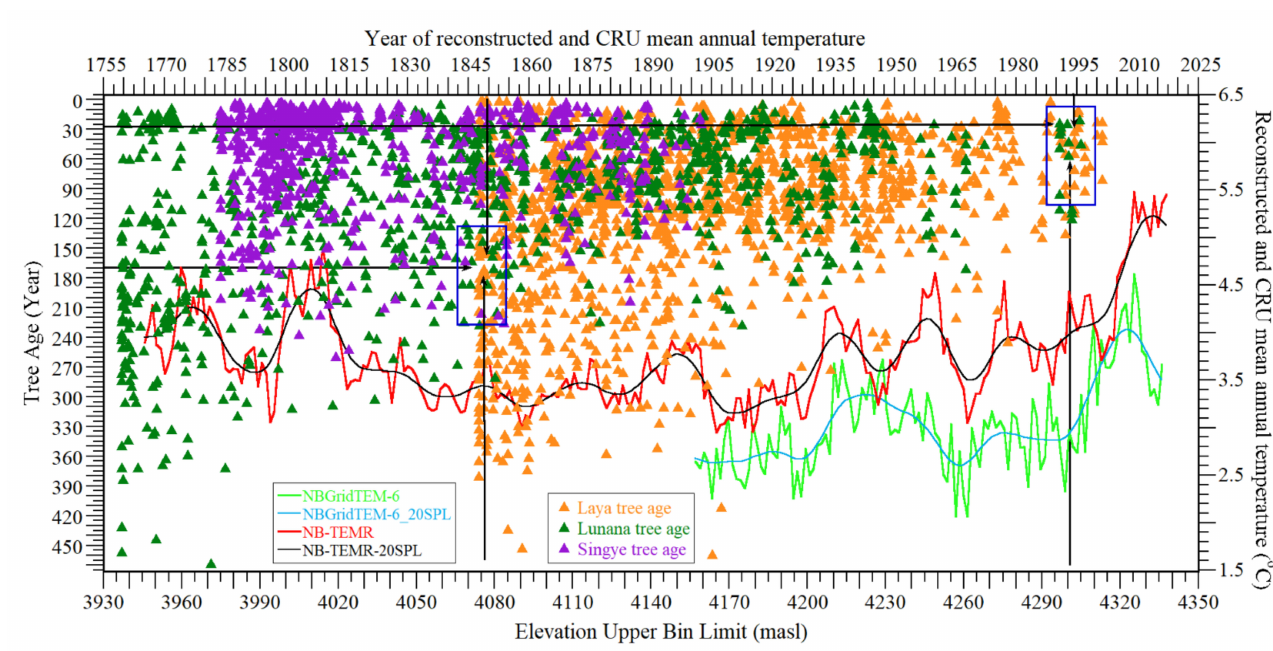
Figure 9. Tree age distribution against elevation and mean annual temperature. Green triangle, golden triangle and purple triangle represent tree age (year) distribution against elevation in Lunana, Laya and Singye laid on side Axis Y1 and X1. NB-TEMR (red line with black smoothing spline) and NBGridTEM-6 (aquamarine line with blue smoothing spline) are protracted on side Axis Y2 and X2. Arrows (black) and rectangles (blue) indicate position of tree ages (years) in earlier past year at lower elevation and recent year at higher elevation depicting shift of treeline